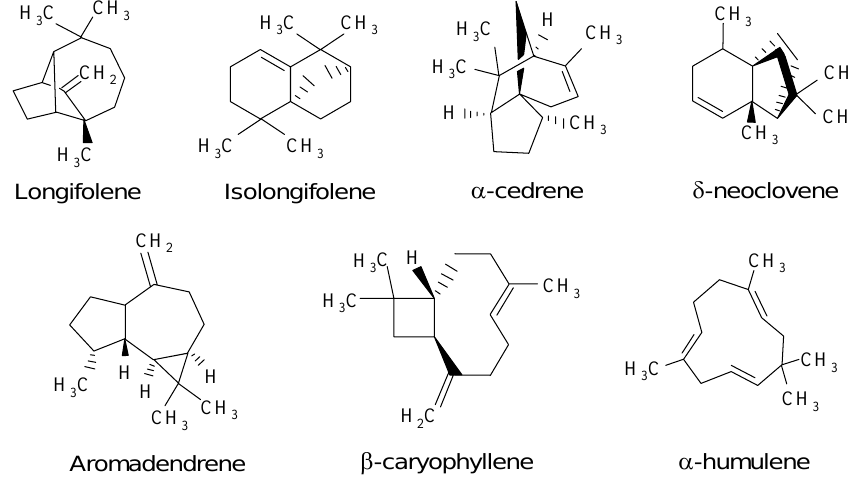
Fig. 2. Molecular structures of the seven sesquiterpenes studied.